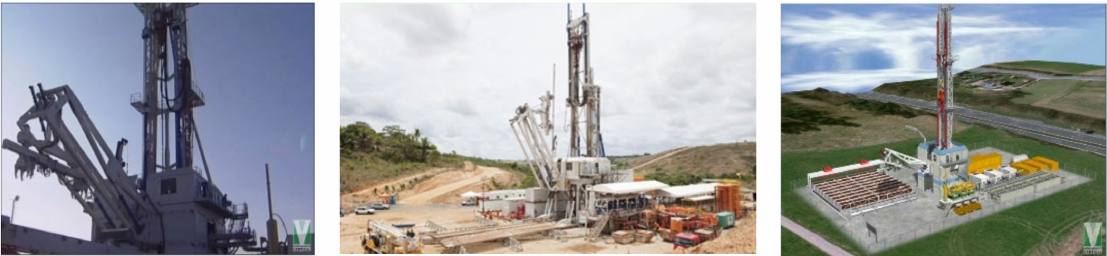
Figure 2. Terra Invader 350 drilling